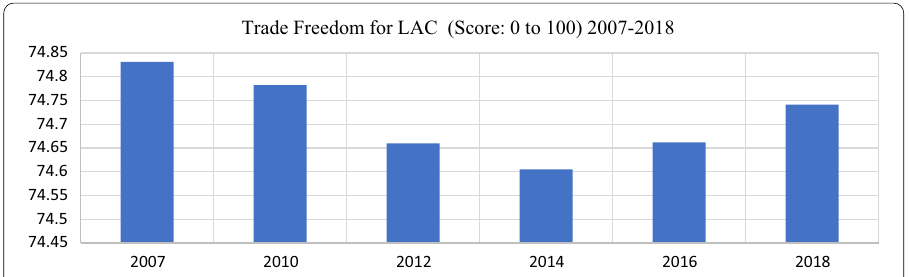
Fig. 4 LAC region Trade Freedom (TRFR) from 2007 to 2018. Source: World Bank (2021)